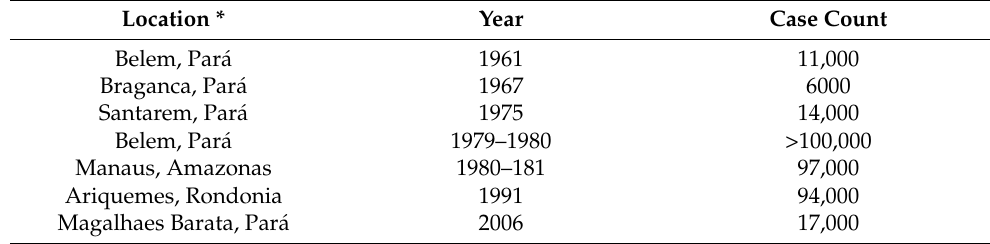
Table 1. OROV outbreaks with large human case counts in Brazil